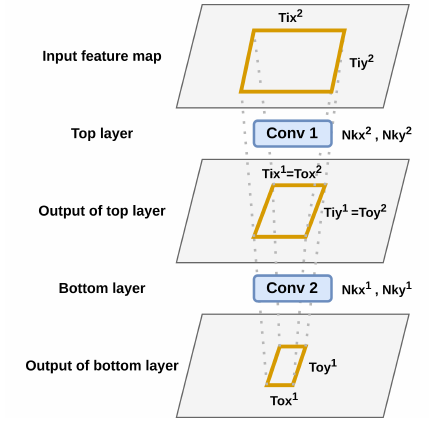
Figure 5. Tiling multiple